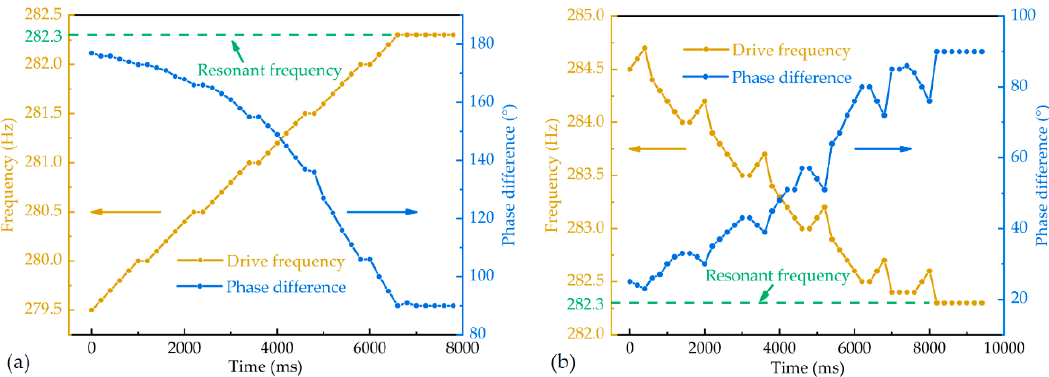
Figure 10. Test results of the frequency modulation algorithm. ( a ) Initial frequency is lower than the resonant frequency; ( b ) initial frequency is higher than the resonant frequency.